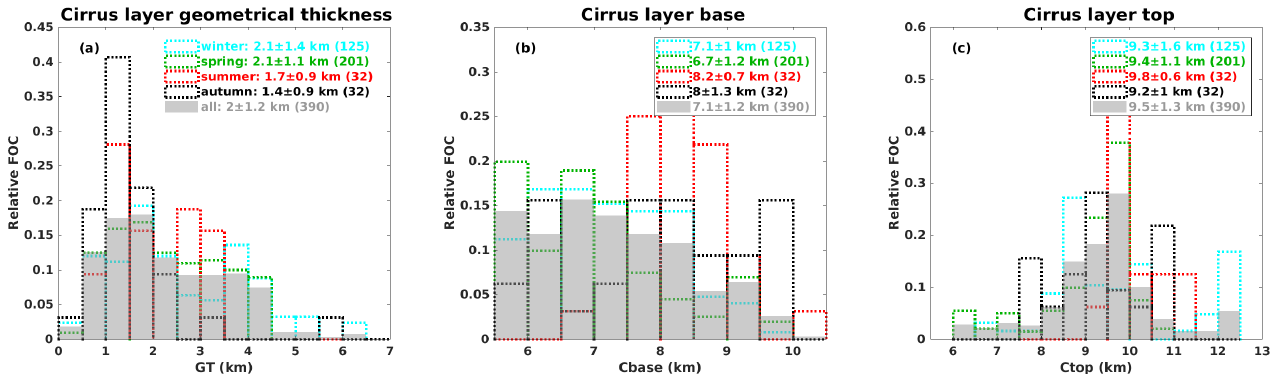
Figure 3. Relative frequency of occurrence (FOC) distribution of geometrical thickness (GT, ( a )), C base ( b ) and C top ( c ). The median ± std (number of observations) is given in the